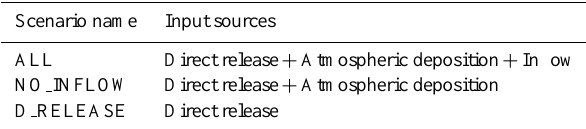
Fig. 1. Schematic representation of inputs of radionuclides into the model domain. Mechanisms include direct release from the 1F NPP, atmospheric deposition, and inflow of radionuclides deposited into the ocean outside the model domain. Table 2. Simulation